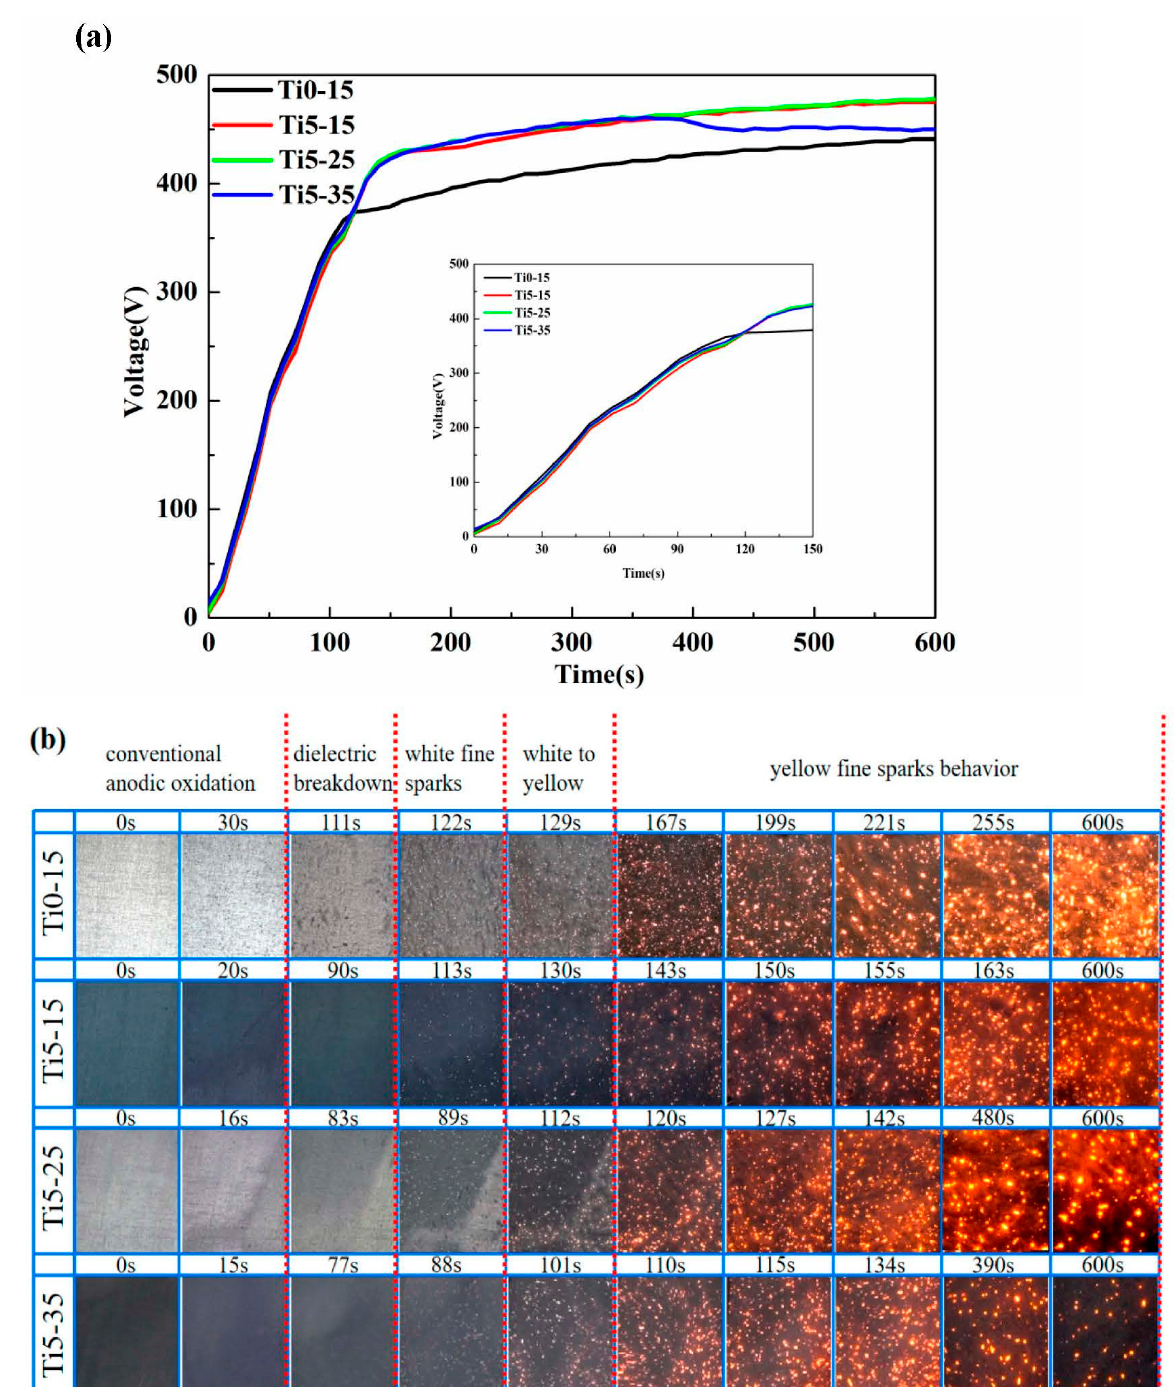
Figure 1. ( a ) Voltage-time curves and ( b ) evolution of the micro-discharge of Ti0-15, Ti5-15, Ti5-25 and Ti5-35 micro-arc oxidation for 10 min.